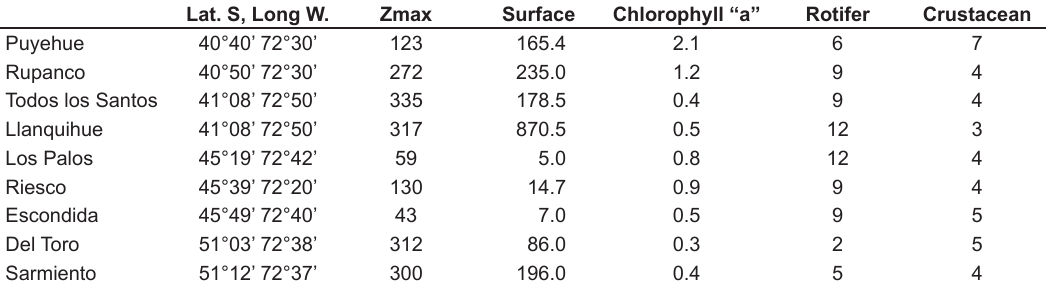
Table 1. Geographical location, maximum depth (Zmax in m), surface (km 2 ), chlorophyll “a” concentration (μg/L), and rotifer and crustacean species number for sites considered in the present